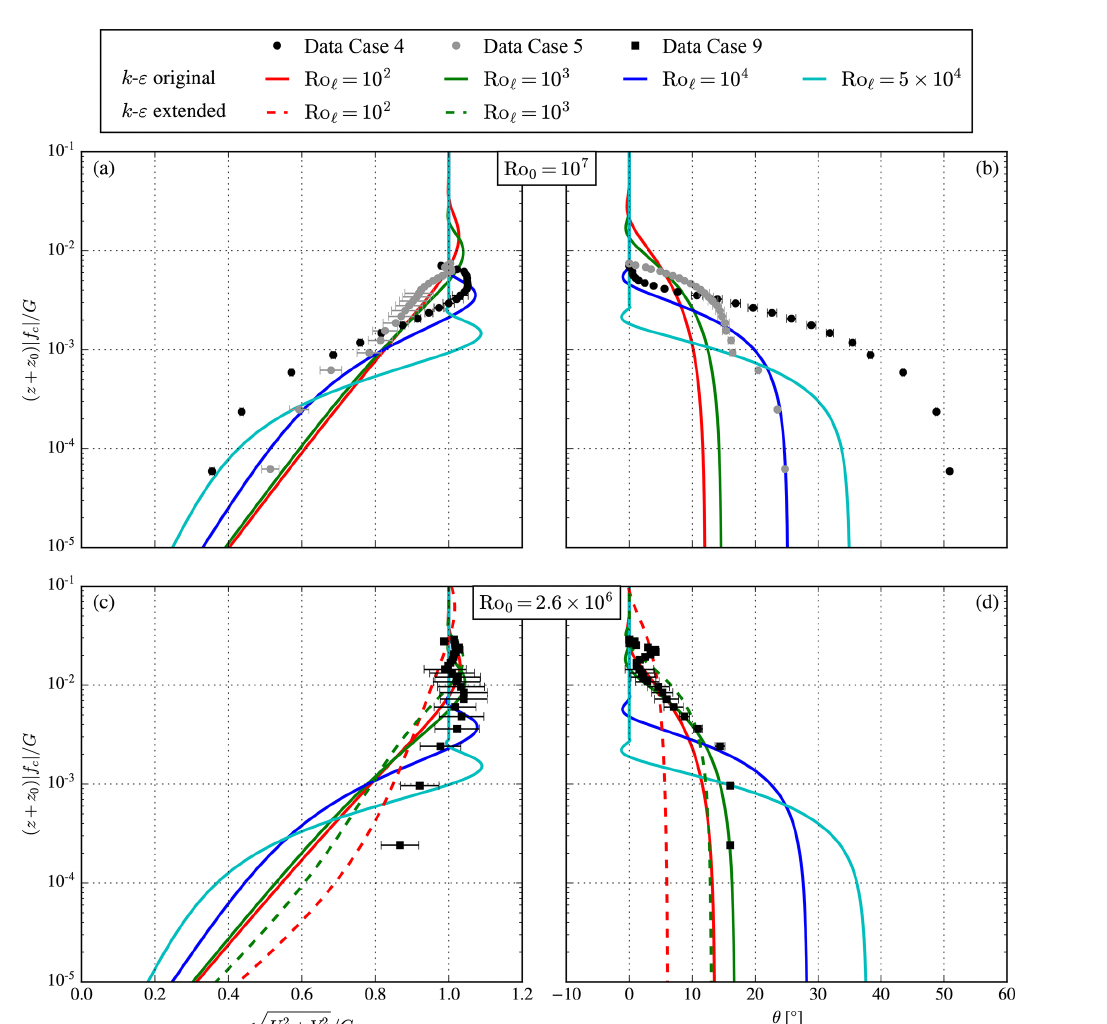
Figure 9. ABL measurements from Peña et al. (2014) compared to simulation results of the original limited-length-scale k – ε model of Apsley and Castro (1997), for a range of Ro (cid:96) . (a, c) Wind speed. (b, d) Wind direction. Unstable Case 9 (c, d) is also simulated with our extension to unstable surface layer stratification (dashed lines), with Ro L (i.e., 1 /L ) from Table −